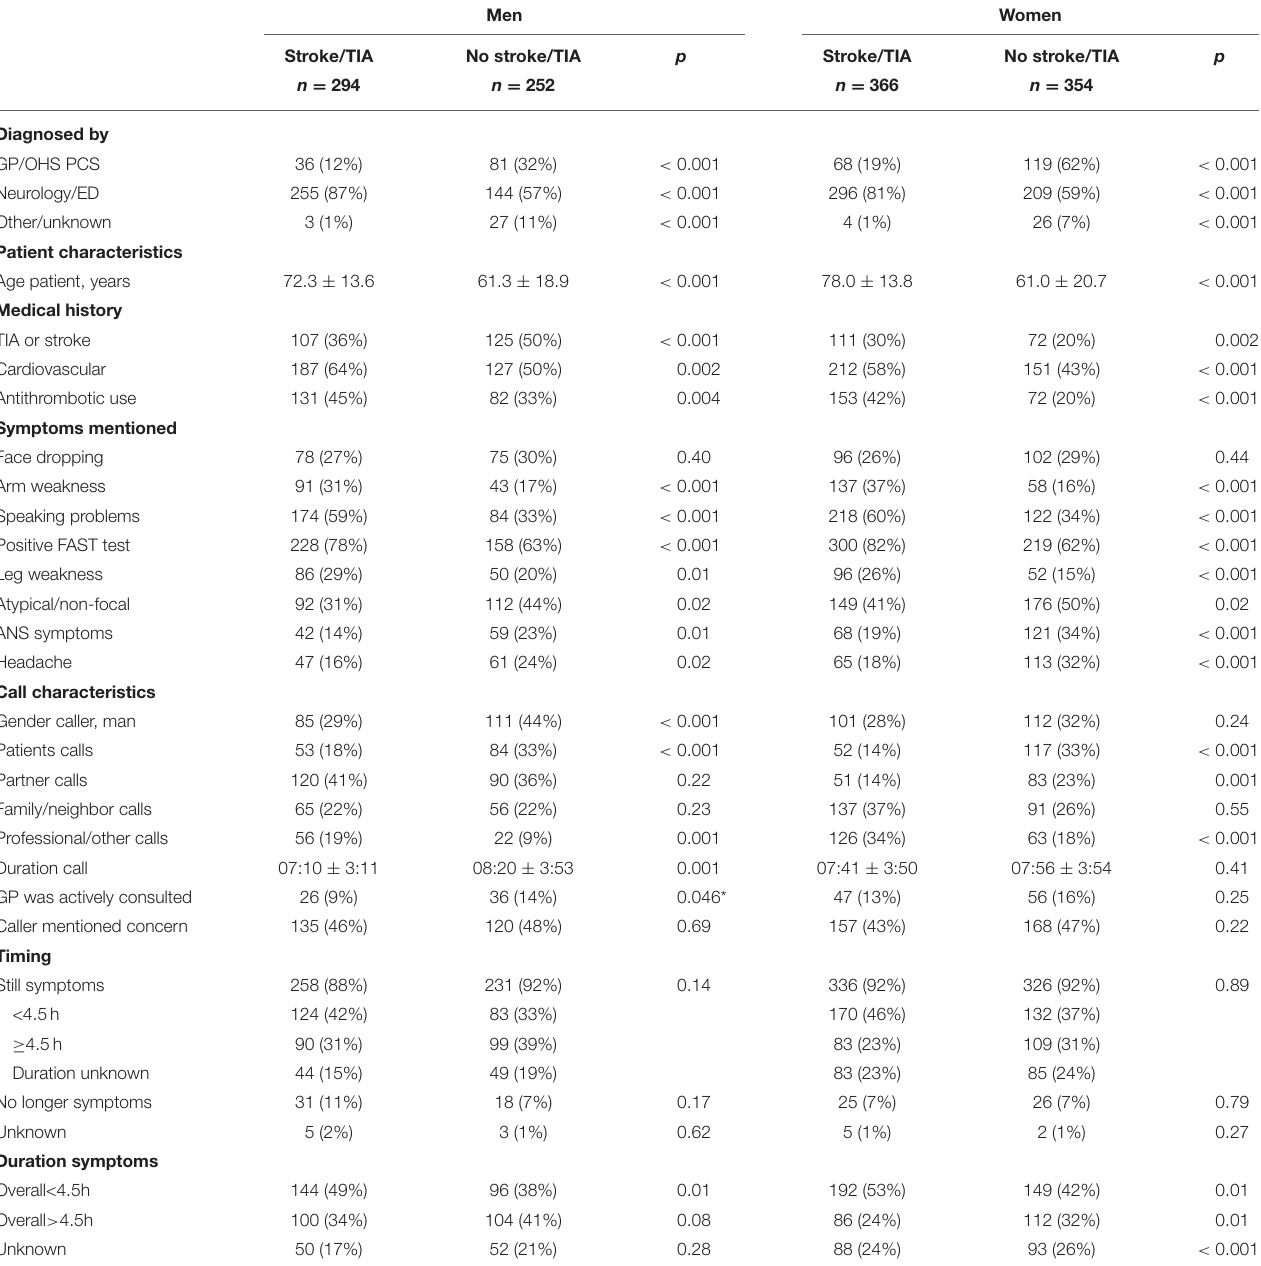
TABLE 3 | Patient and call characteristic comparison by gender of subjects with and without